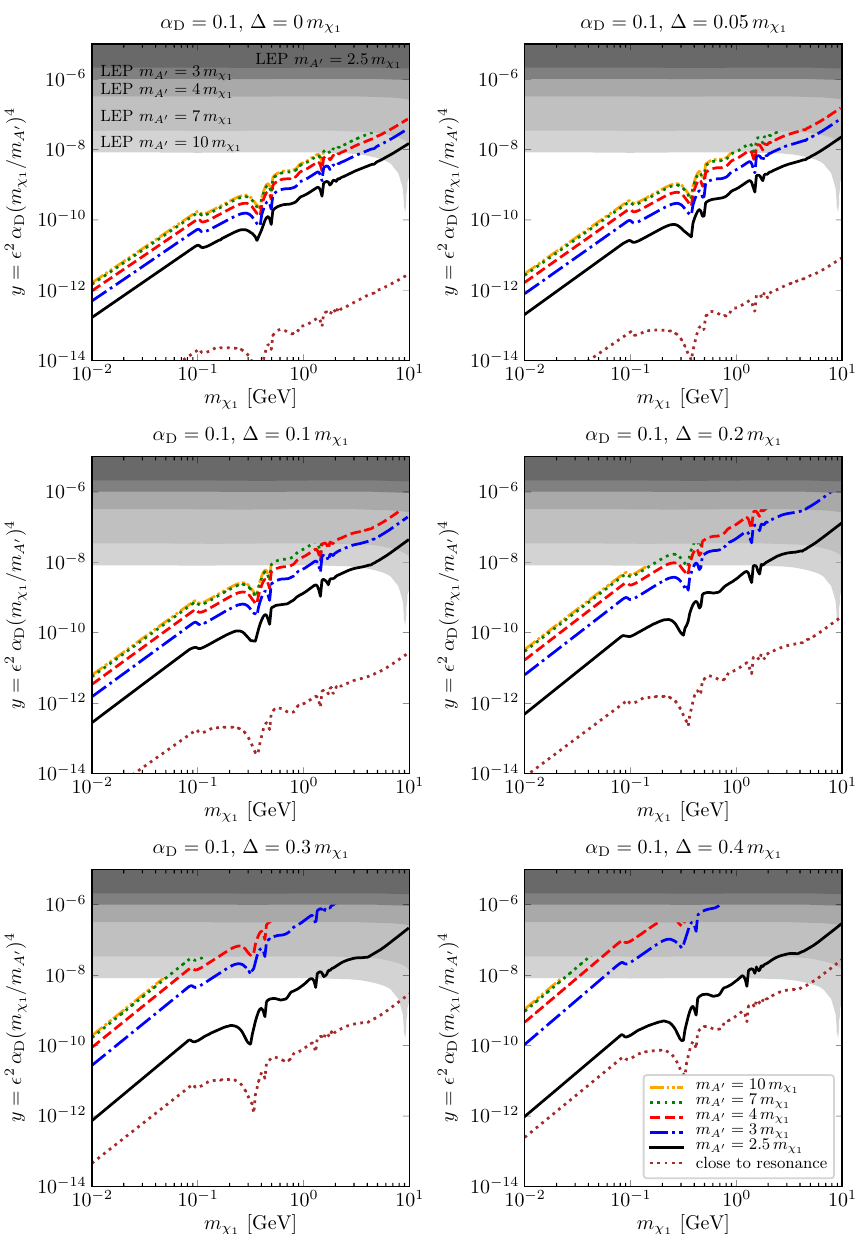
2 = 0 : 12 [23]) for the inelastic DM model. We show various Figure 1 . Thermal targets ((cid:10) DM h DM mass di(cid:11)erences (cid:1) =m (cid:31) = [0 ; 0 : 05 ; 0 : 1 ; 0 : 2 ; 0 : 3 ; 0 : 4] (di(cid:11)erent panels) and various mediator 1 mass ratios m A =m (cid:31) = [2 : 5 ; 3 ; 4 ; 7 ; 10] (di(cid:11)erent lines in each panel). For the line labelled ‘close 1 0